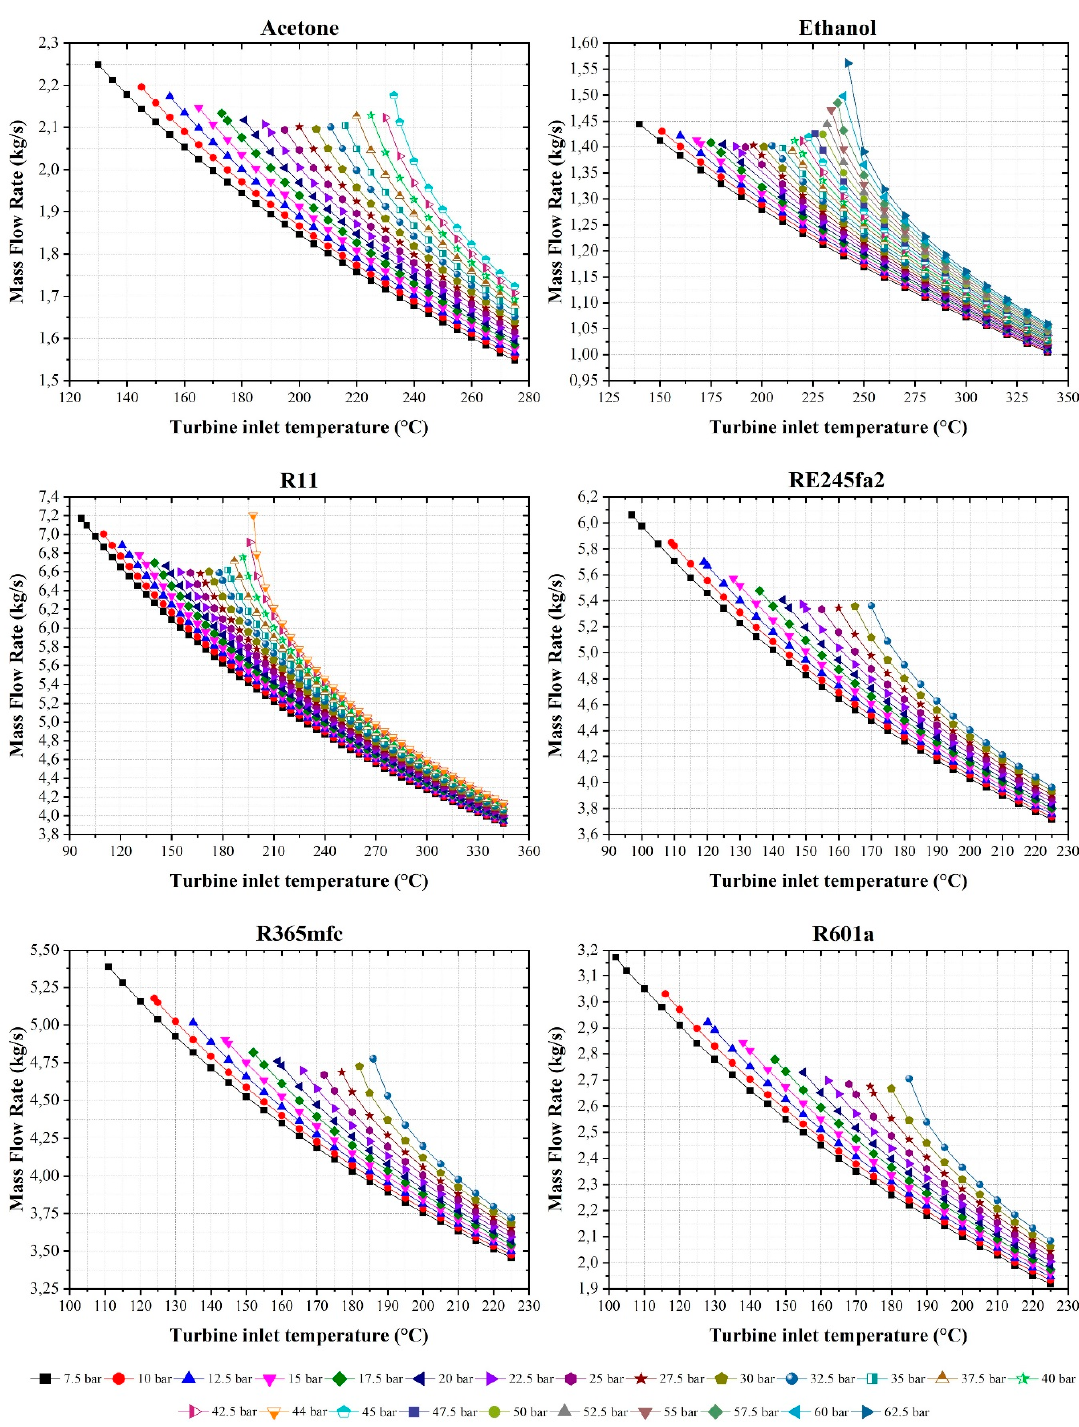
Figure 3. The mass flow rate of the organic working fluids for varying turbine inlet temperatures and turbine inlet pressures.